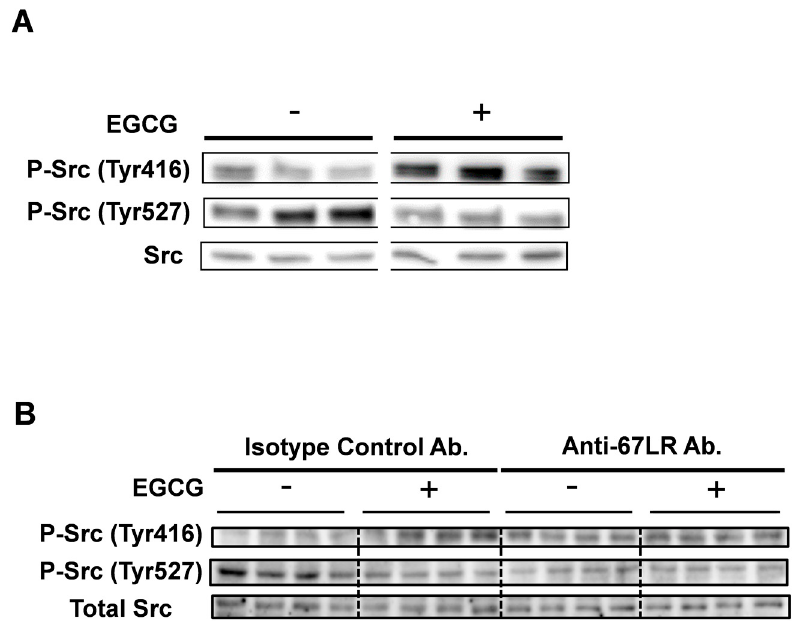
Figure 2. EGCG induced phosphorylation of Tyr 416 in multiple myeloma cells. ( A ) U266 human multiple myeloma cells were treated with EGCG (10 µ M) for 30 min. Phosphorylation levels of Src were evaluated using Western blotting ( n = 3). ( B ) U266 human multiple myeloma cells were pretreated with the anti-67LR antibody or with the isotype control antibody and treated with EGCG (10 μ M) for 30 min. Src phosphorylation levels were evaluated using Western blotting ( n = 4).